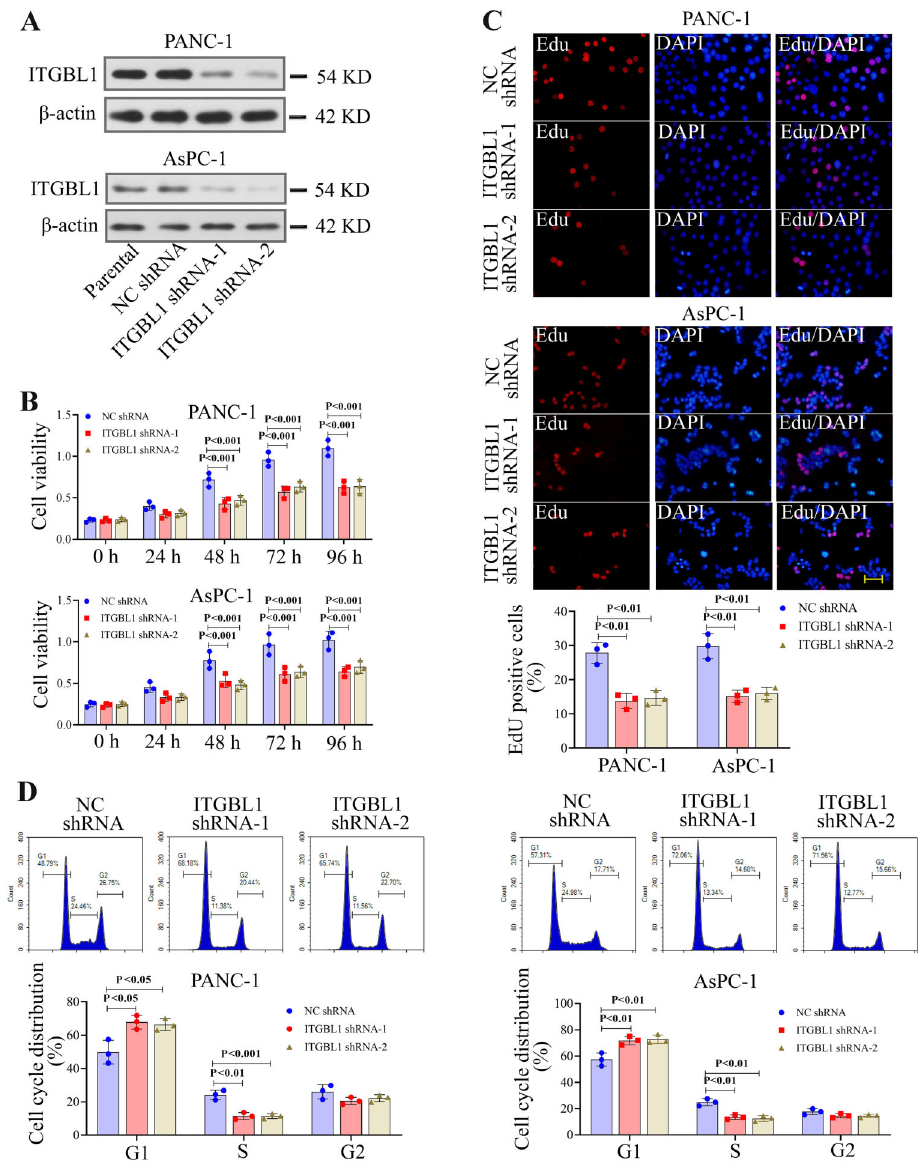
Figure 3. ITGBL1 knockdown inhibited the proliferation of pancreatic cancer cells. A , Relative ITGBL1 protein expression, standardized by b -actin, in ITGBL1-silenced cells was performed by western blot. B , Cell viability of ITGBL1-silenced pancreatic cancer cells was detected by MTTassay. C , EdU assay was performed on pancreatic cancer cells with ITGBL1 downregulation. Scale bar=50 m m. D , Cell cycle distribution of ITGBL1-silenced cells was measured by a fl ow cytometer. Data are reported as means ± SD for N=3 (ANOVA). NC: negative